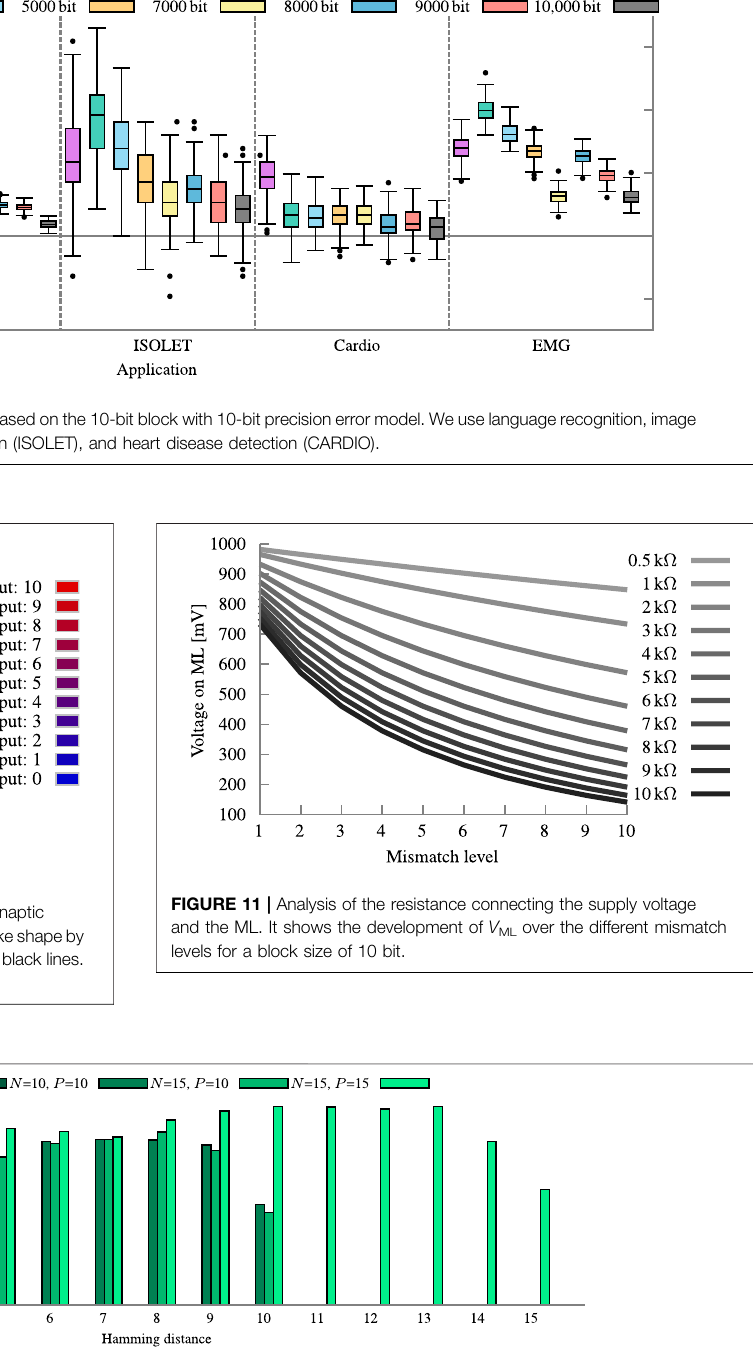
FIGURE 10 | Error probability of our four circuit con fi gurations. The error probability is the summary of how likely it is to get the wrong result for a given input. Analysis is done at respective block size ( N ) and precision ( P ).